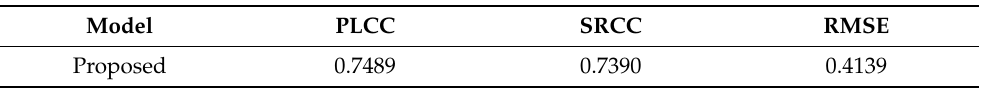
Table 5. The Proposed Method is trained on the IETR database, and the performance of our proposed method is tested on the IRCCyN/IVC